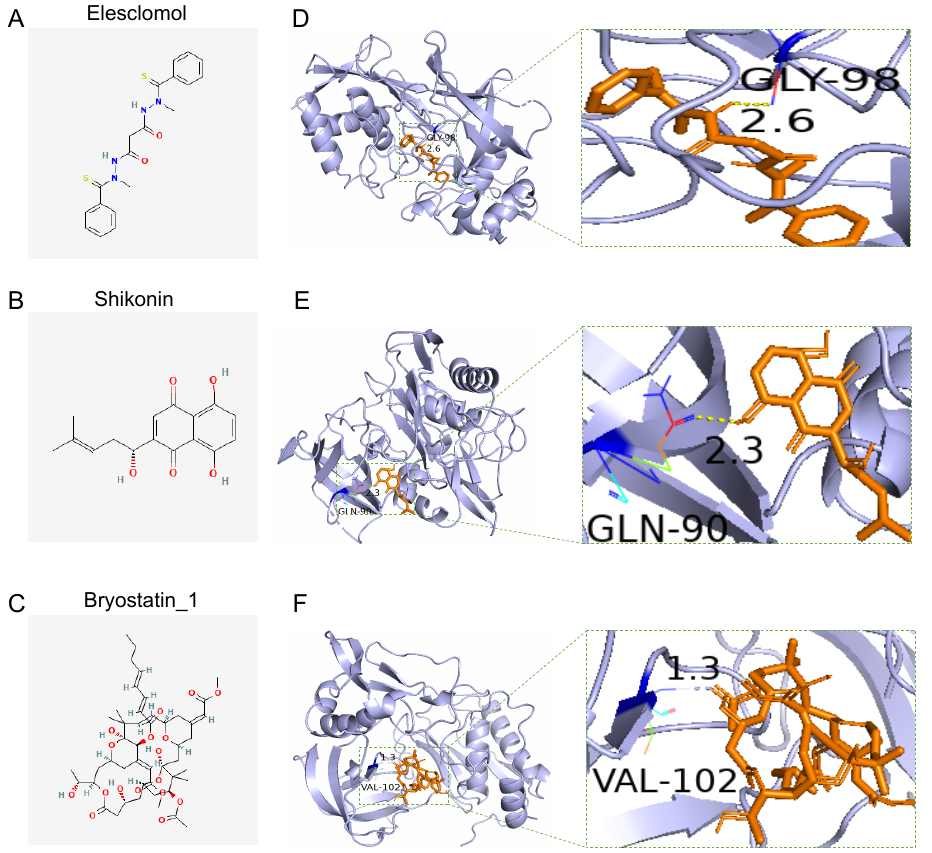
Figure 11. Molecular-docking analysis. ( A – C ) Elesclomol ( A ), Shikonin ( B ), and Bryostatin 1 ( C ) were screened-out by drug sensitivity analysis. Note that drug sensitivity analysis is shown in Supplementary Figure S3. ( D – F ) 3D structures and binding modes showing the formed hydrogen bonds between the predicted pocket of TIMP1 and Elesclomol ( D ), Shikonin ( E ), and Bryostatin_1 ( F